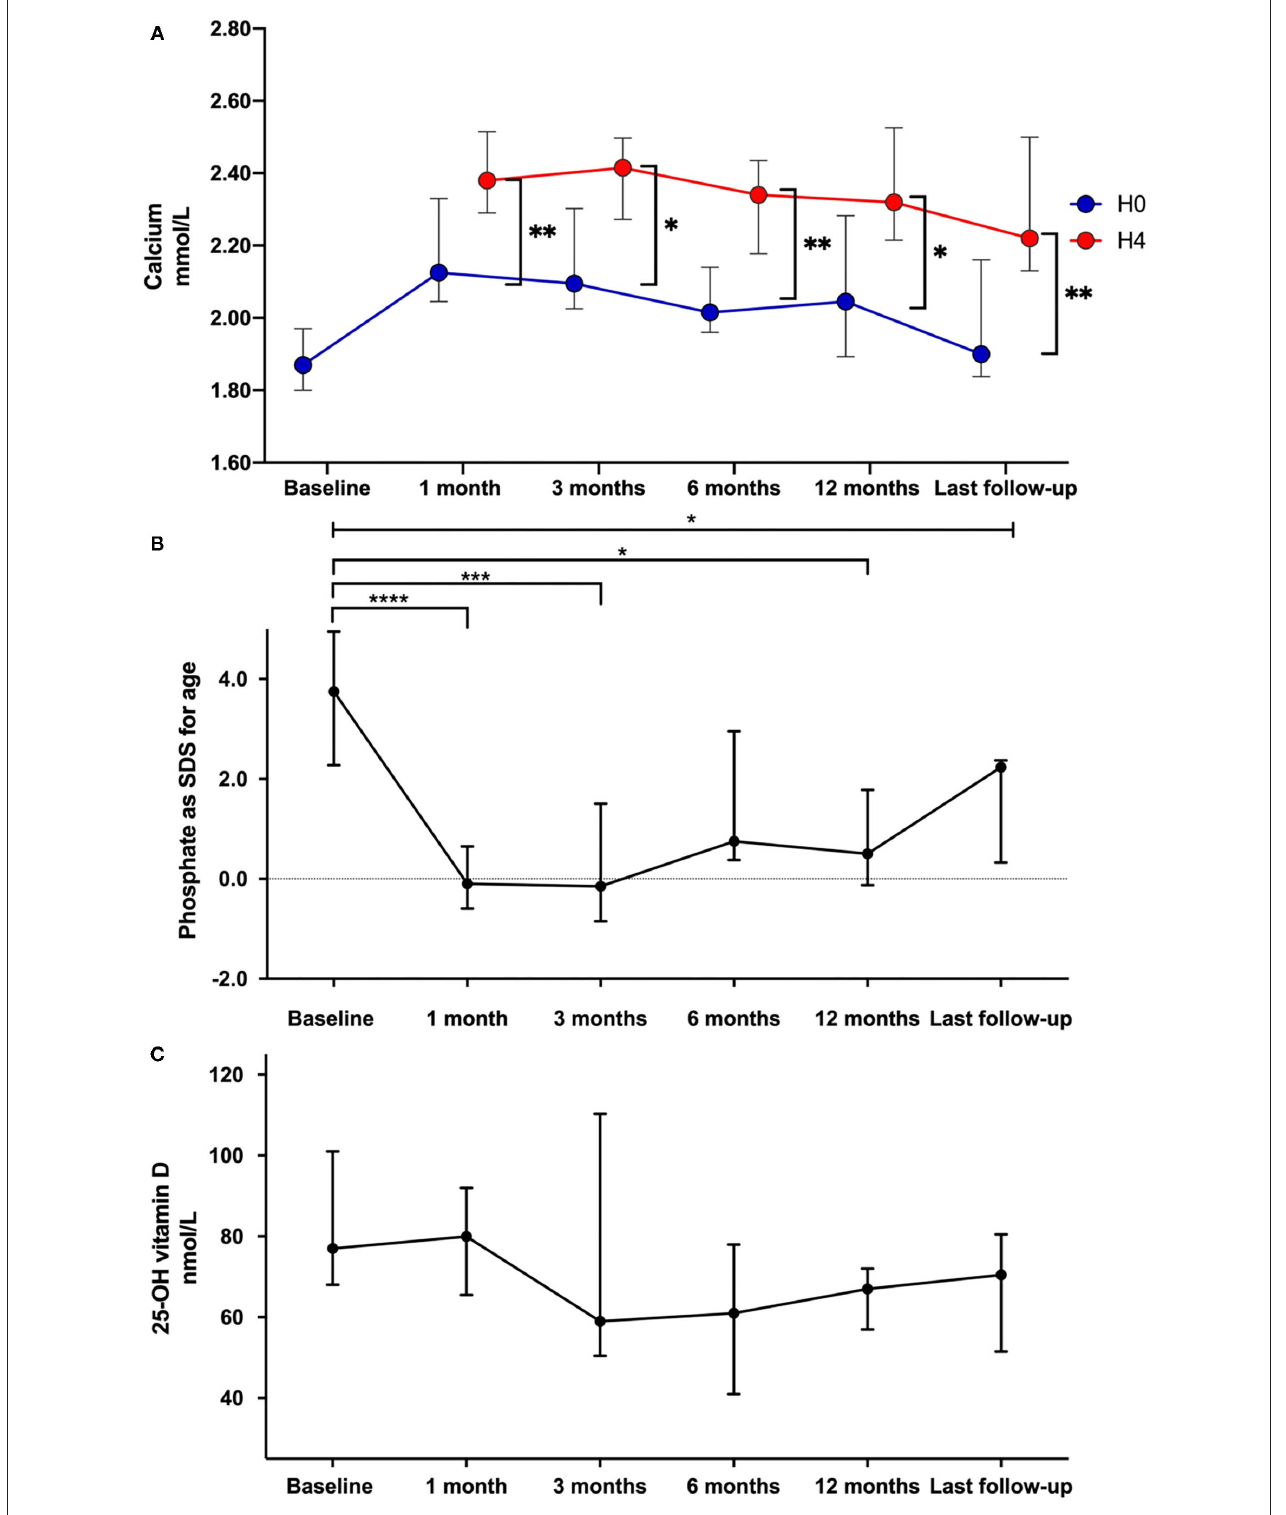
FIGURE 1 | Comparison of total calcium (A) , phosphate levels as z -score for age (B) , and 25-OH vitamin D (C) data at teriparatide initiation and during follow-up. Each dot on the graph represents median with interquartile range of different biomarkers levels at the different time-points. Statistical analyses were performed with Kruskall Wallis test: * p < 0.05, ** p < 0.01, *** p < 0.001, and **** p < 0.0001.